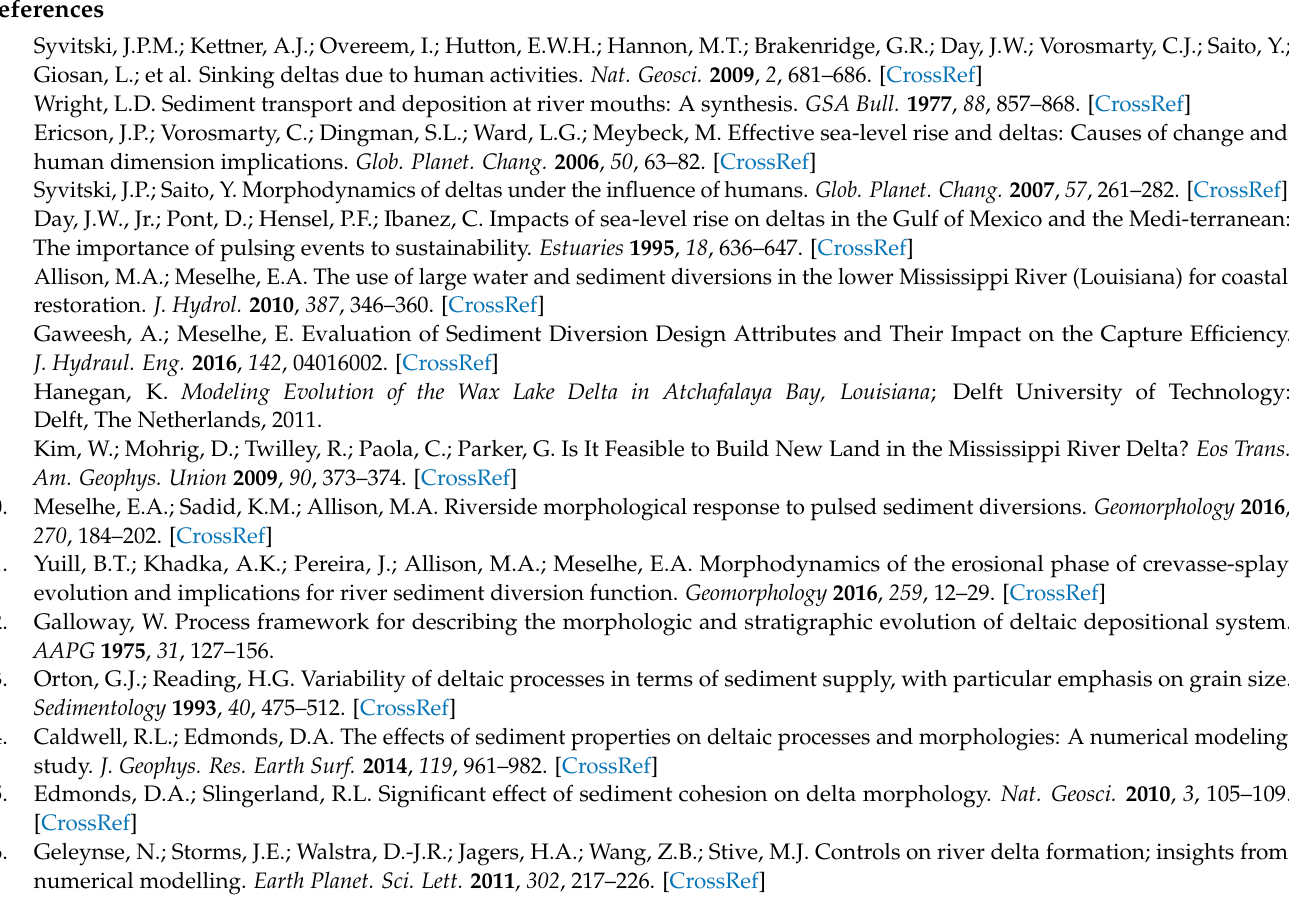
Figure A4. Comparison of modeled and measured (ADCP) velocities at select distributary channel locations—see Figure A1 for locations.